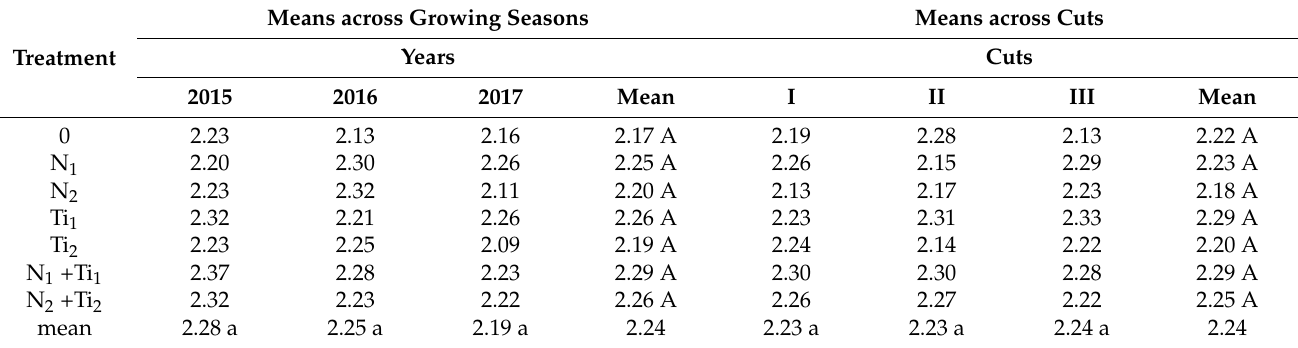
Table 7. Dry matter intake (DMI) of Festulolium braunii